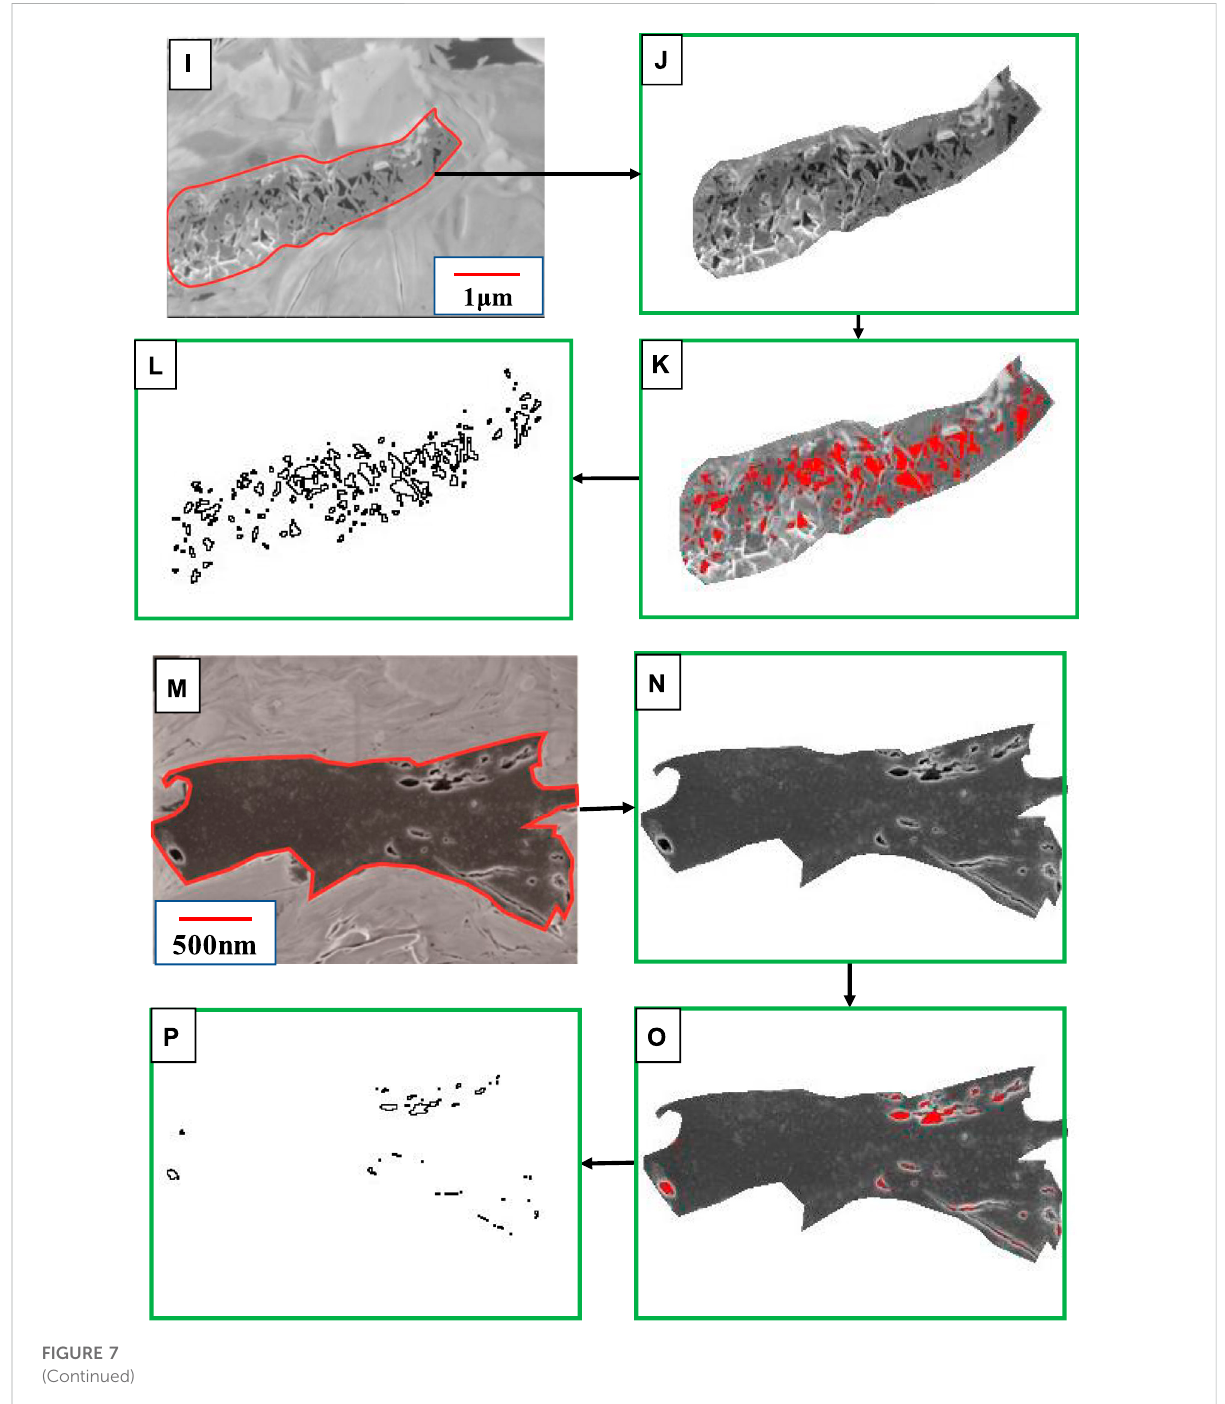
diameter, fairly good roundness of pore edges and complex shapes, thus altogether contributing to their large surface porosity, i.e., 17.791, 11.147 and 12.991%, respectively. Therefore, these pores are the main reservoir space of shale oil and gas. Funginite pores have medium pore diameter, good roundness, average number, good roundness